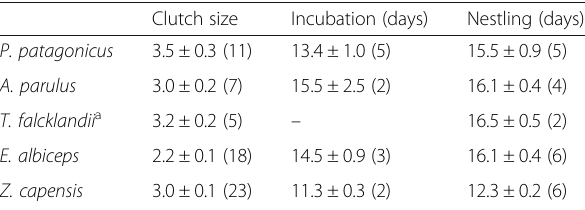
Table 2 Clutch size and duration of incubation and nestling periods Clutch size Incubation (days) Nestling